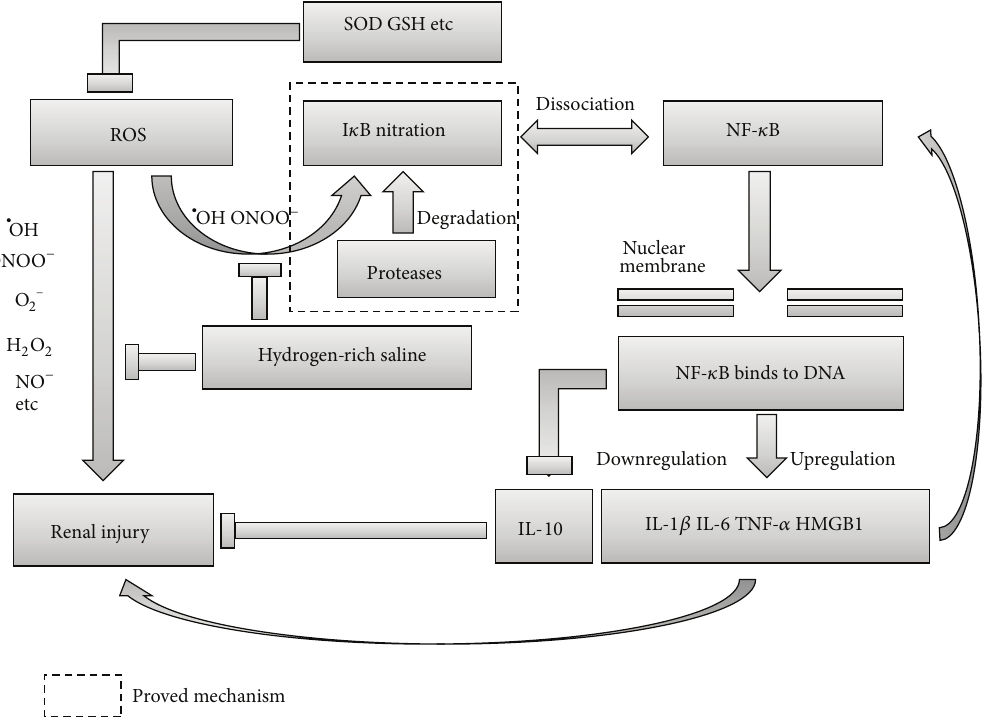
Figure 10: The protective mechanisms involved in the inflammatory response of renal tissues during severe acute pancreatitis. Hydrogen- rich saline protects the acute renal injury by antioxidant effect directly and by scavenging the overproduced ∙ OH and ONOO − to inhibit the activation of NF- 𝜅